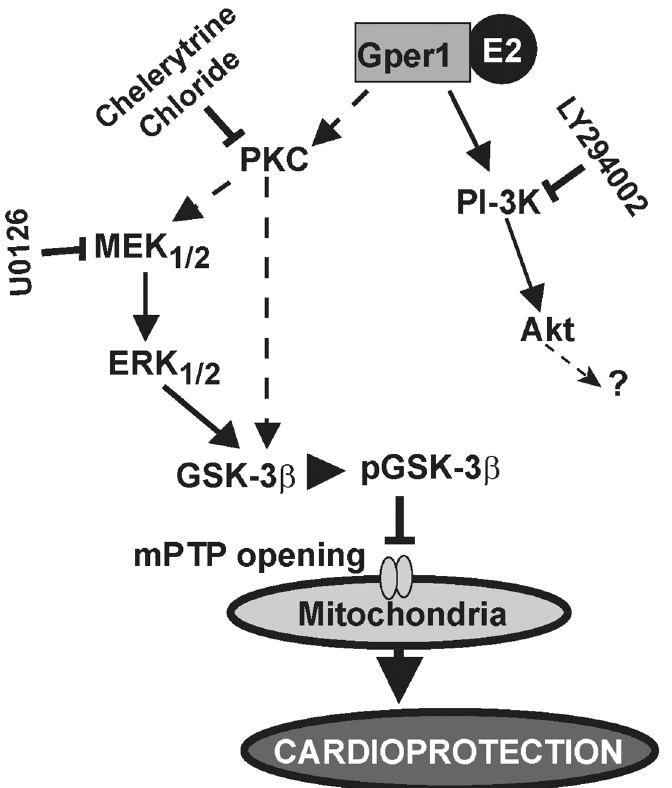
Fig 9. Salvage mechanisms triggered by E2 via Gper1 during I/R. E2 binding to Gper1 may initially trigger protein kinase C (PKC) translocation. PKC could directly or via activation of MEK 1/2 /ERK 1/2 pathway increase phosphorylation of GSK-3 β , which in turn would inhibit mPTP opening resulting in cardioprotection. Chelerythrine chloride, inhibitor of PKC translocation; U0126, inhibitor of the MEK 1/2 /ERK 1/2 -pathway; and LY294002, inhibitor of PI-3K. E2 through Gper1 can also induce a transient activation of PI-3K/Akt pathway, but this activation does not play an important role in the acute E2 induced cardioprotection after I/R. Black arrows, pathways demonstrated in this work. Dashed arrows, putative pathways.?, unknown